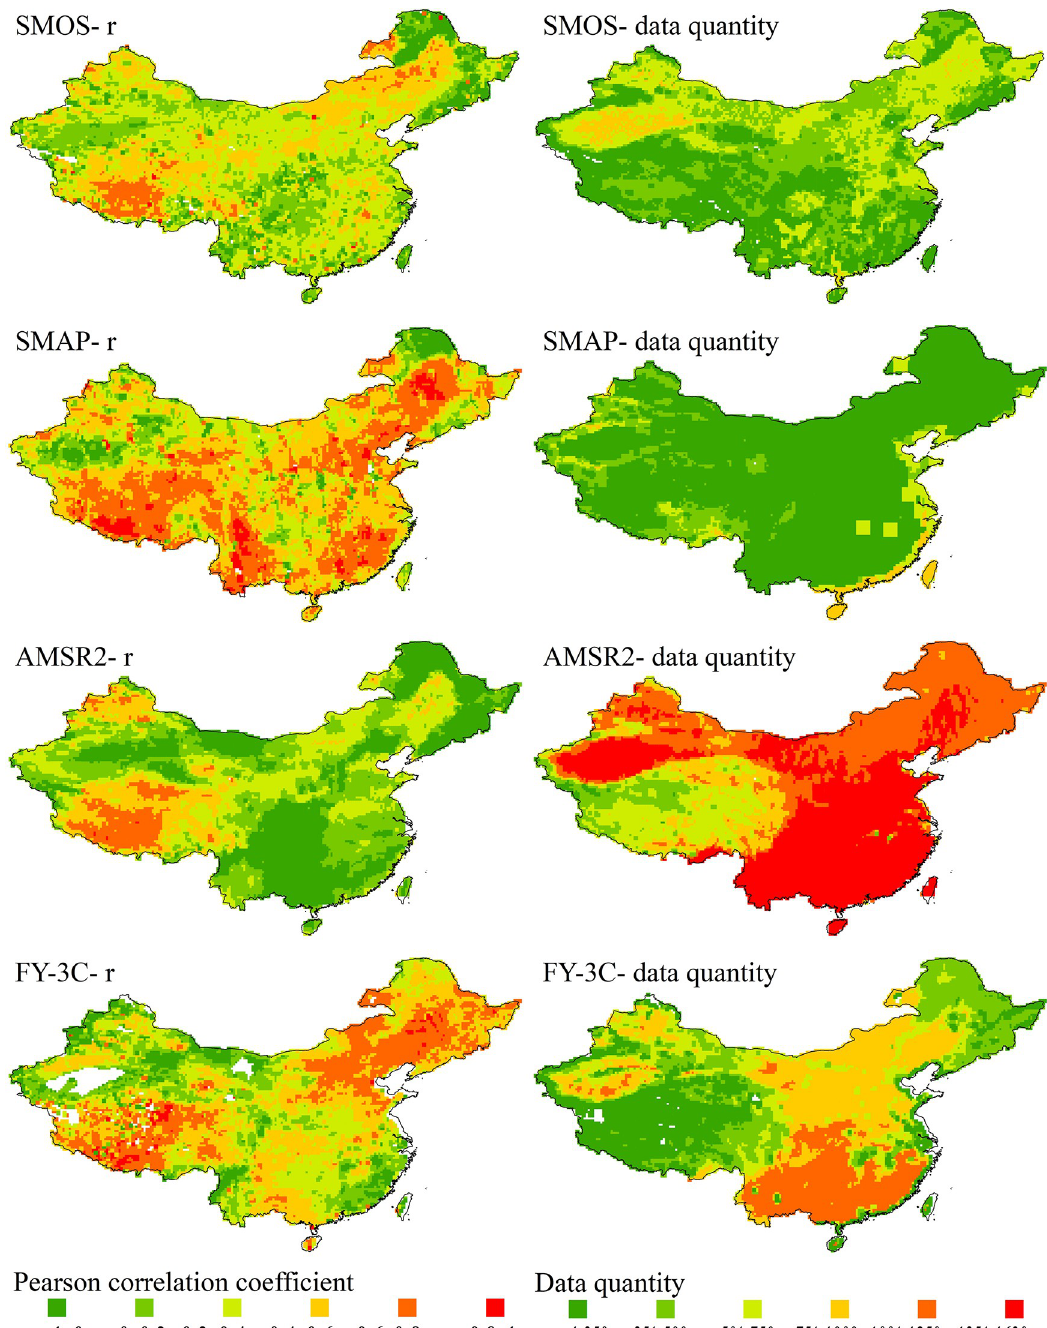
Fig 1. Correlation coefficients and data quantity distributions over China for passive microwave soil moisture products; grids with less than 5 data points are blank. correlation between GLDAS and SMOS or SMAP were in parts of northeast and central China, north of QTP. Correlations between GLDAS and AMSR2 were similarly distributed, but there were more areas of low correlation. FY-3C performed better than the other three